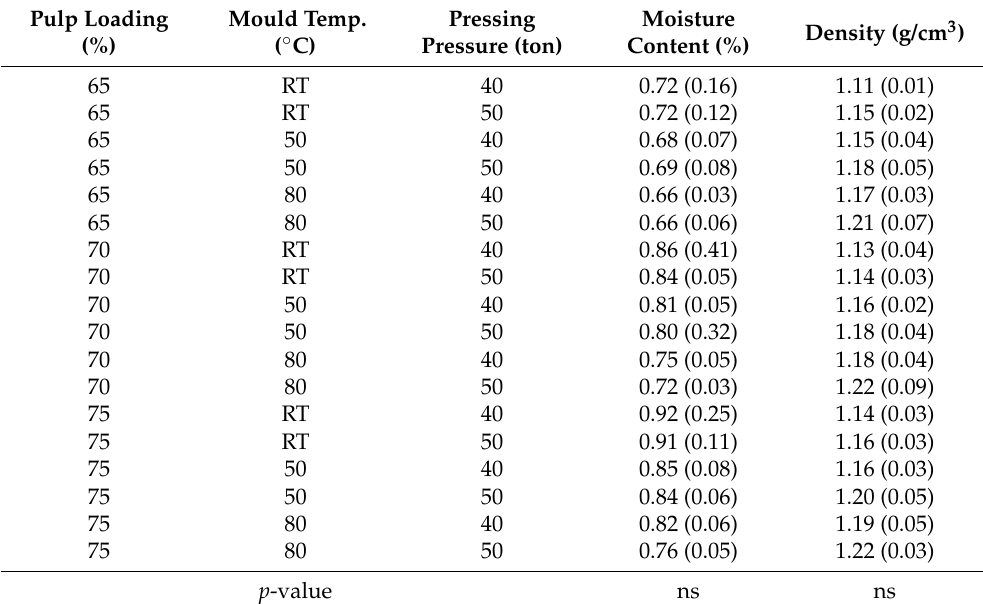
Table 7. Moisture content and density values of PP/OPTP composites with different injection moulding